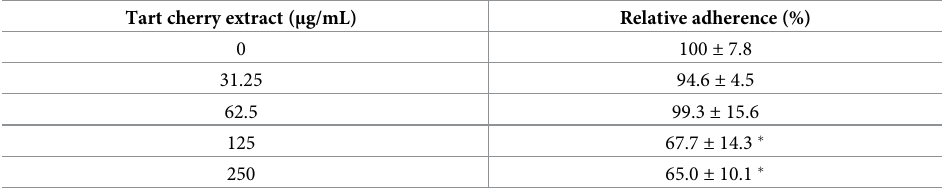
Table 1. Effect of the tart cherry extract on the adherence of P . gingivalis to Matrigel 1 , a basement membrane matrix model.